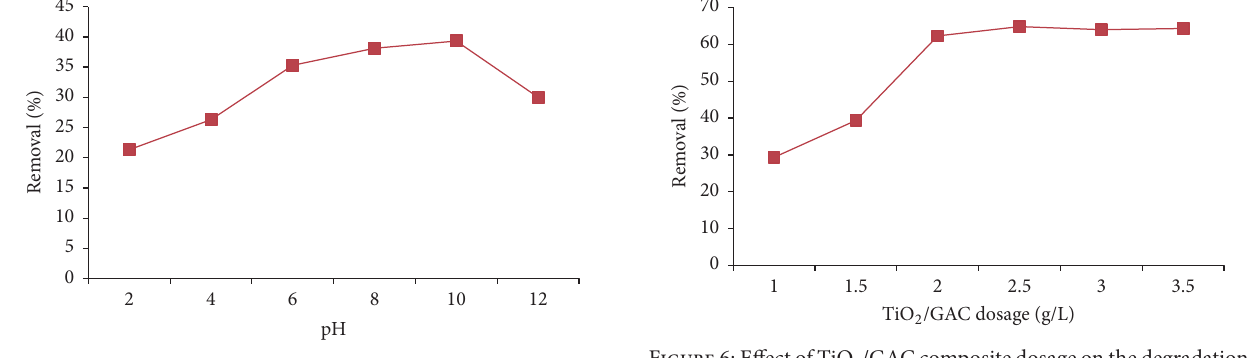
Figure 5: Effect of pH on degradation of furfural. TiO 2 /GAC composite dosage: 1.5g/L, irradiation time: 40 min, and initial furfural concentration: 300 mg/L.